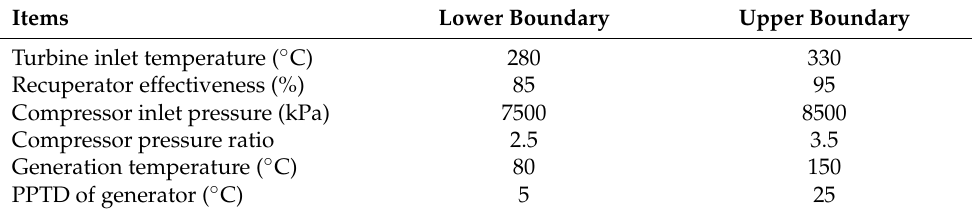
Table 8. Boundary condition of decision variables in the optimization.